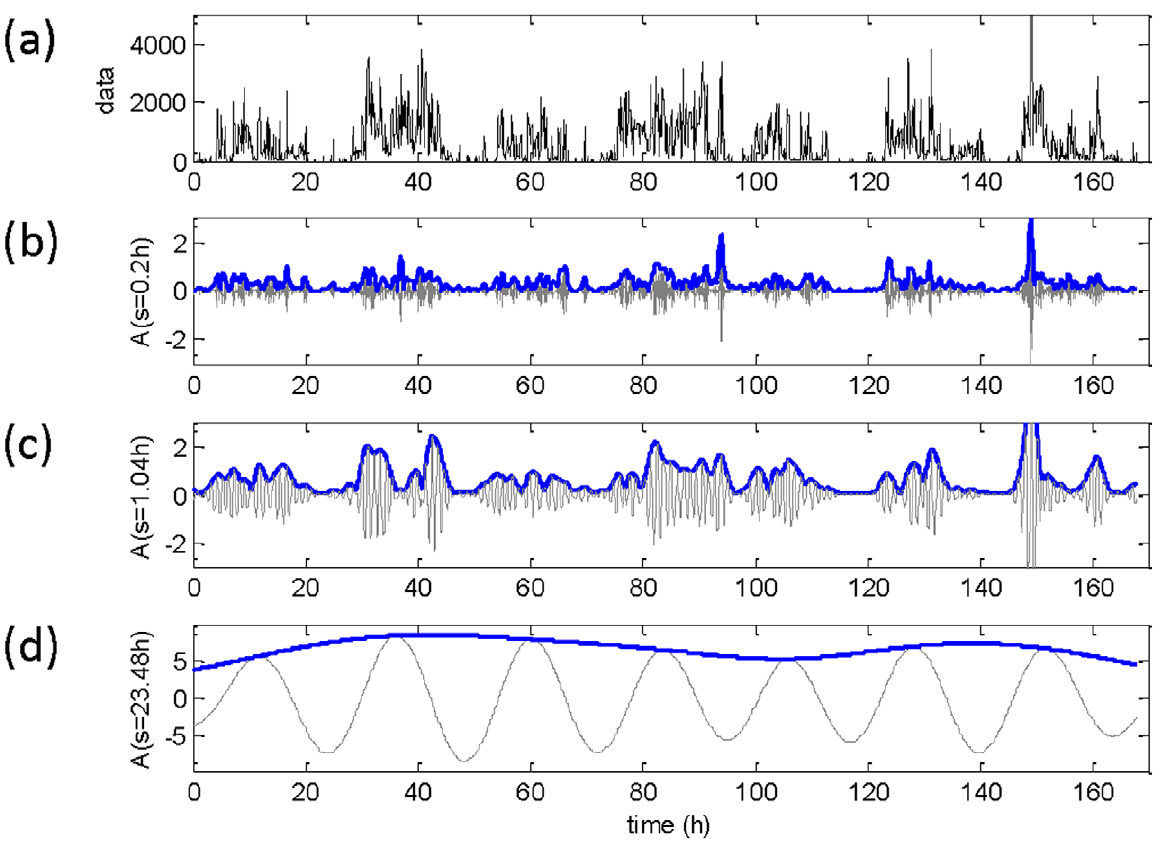
Figure 1. Estimated multi-scale rhythms of motility data obtained by wavelet analysis. (a) Raw data in arbitrary units (a.u) along with the rhythms detected at three different time scales. (b) The detected rhythm (grey line) along with its amplitude (blue line) for a scale of 0.2 h. (c) The corresponding rhythm and amplitude for a scale of 1.04 h. (d) The same measure at a scale of 23.48 h. Wavelet amplitudes are in normalized arbitrary units.